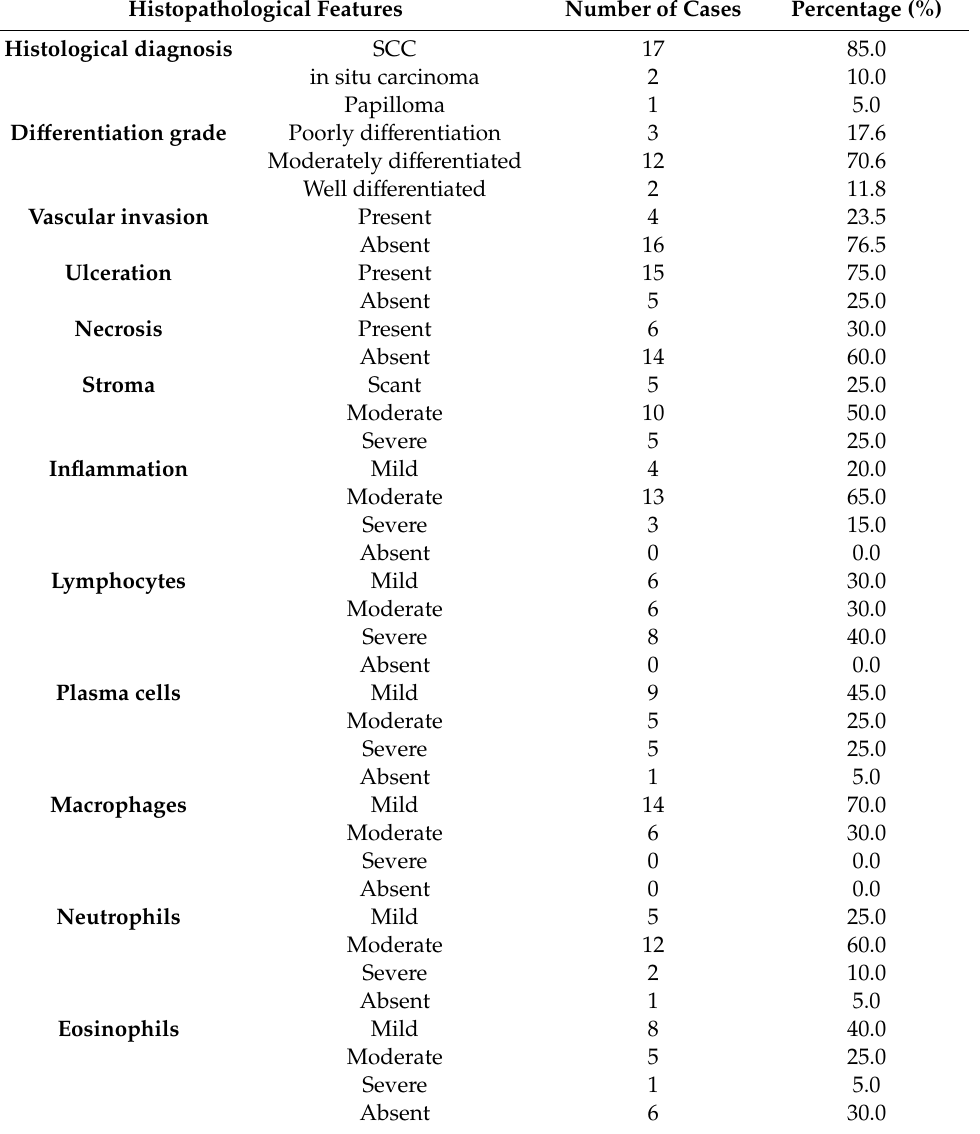
Table 4. Histopathological features of equine penile